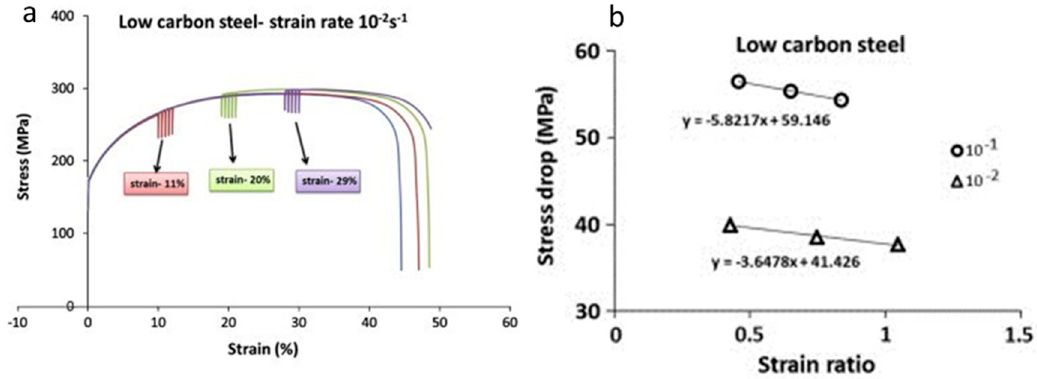
Figure 14. ( a ) Comparison of stress relaxation and monotonic tensile curve; ( b ) stress drop versus strain ratio [99] .